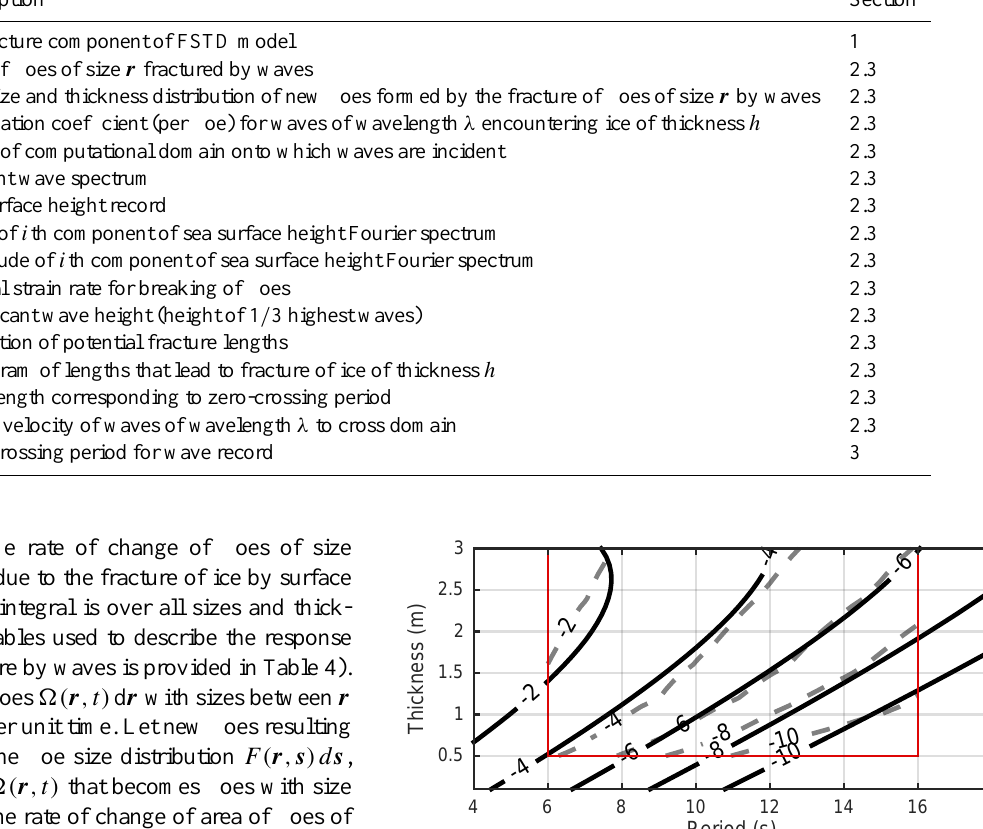
Table 4. Variables used in the representation of the fracture of ice by surface waves in the FSTD model. Variable